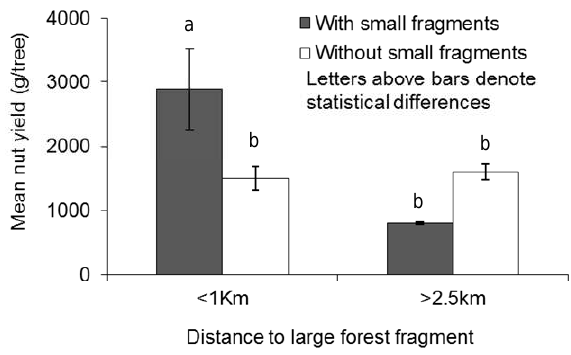
F IGURE 3. Effect of the distance (m) between cashew ( Anacardium occidentale ) plantations and a large (> 100ha) forest fragment on the mean cashew nut yield (g/tree) in the state